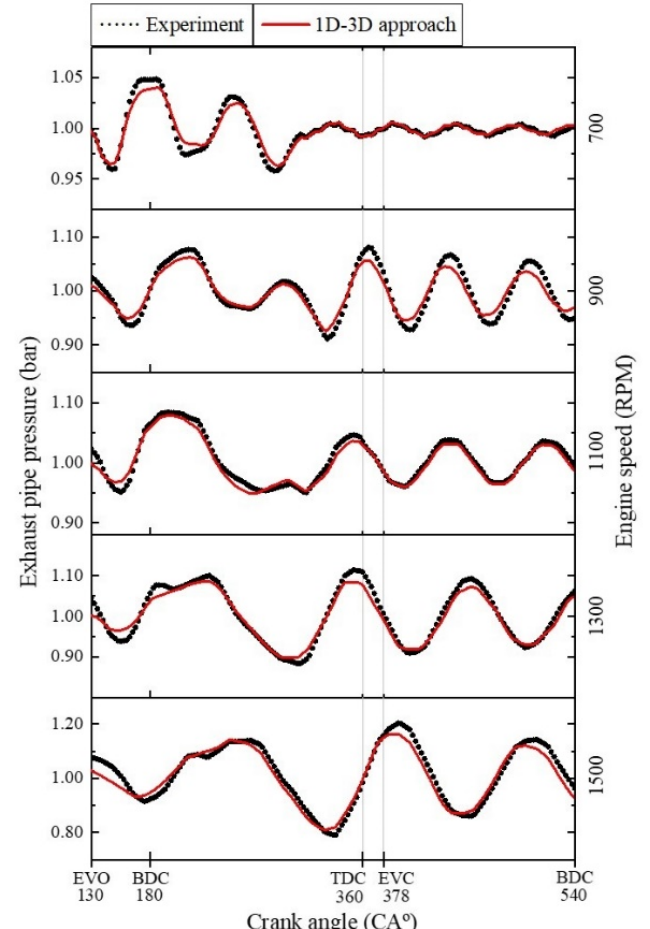
Figure 6. Exhaust pipe pressure of the experiment and the 1D–3D approach numerical analysis.